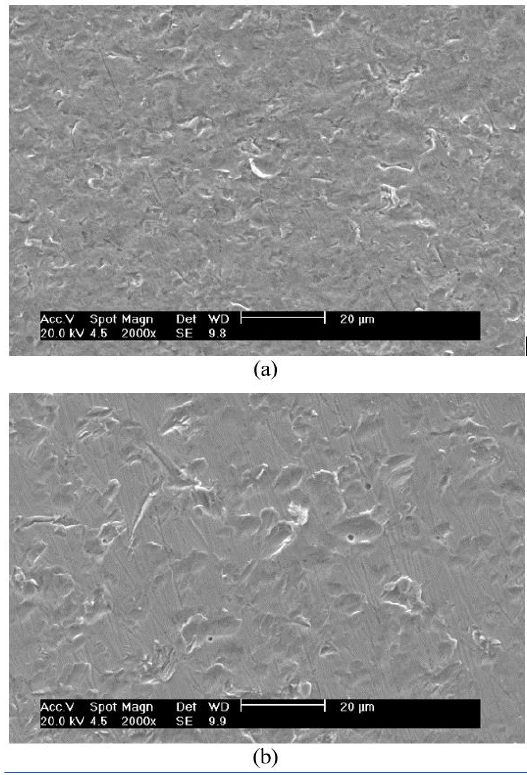
Figure 6. Aspect of typical erosion marks obtained on the surface of the samples tested under corrosion-erosion with 90º (a) central region of the scar, (b) outer